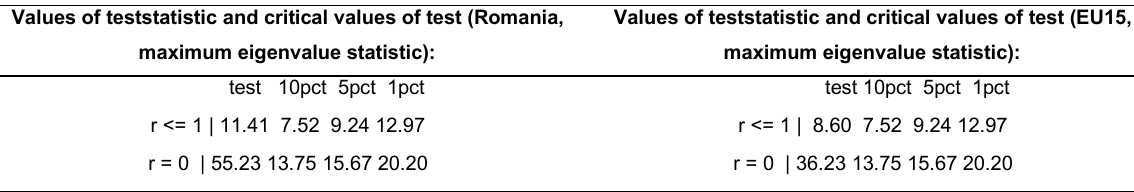
Table 1. Results of the Johansen cointegration test for Romania and EU15 specific variables (in levels). Note: only the case of these two economic entities has been included due to space constraints. Values of teststatistic and critical values of test (Romania,